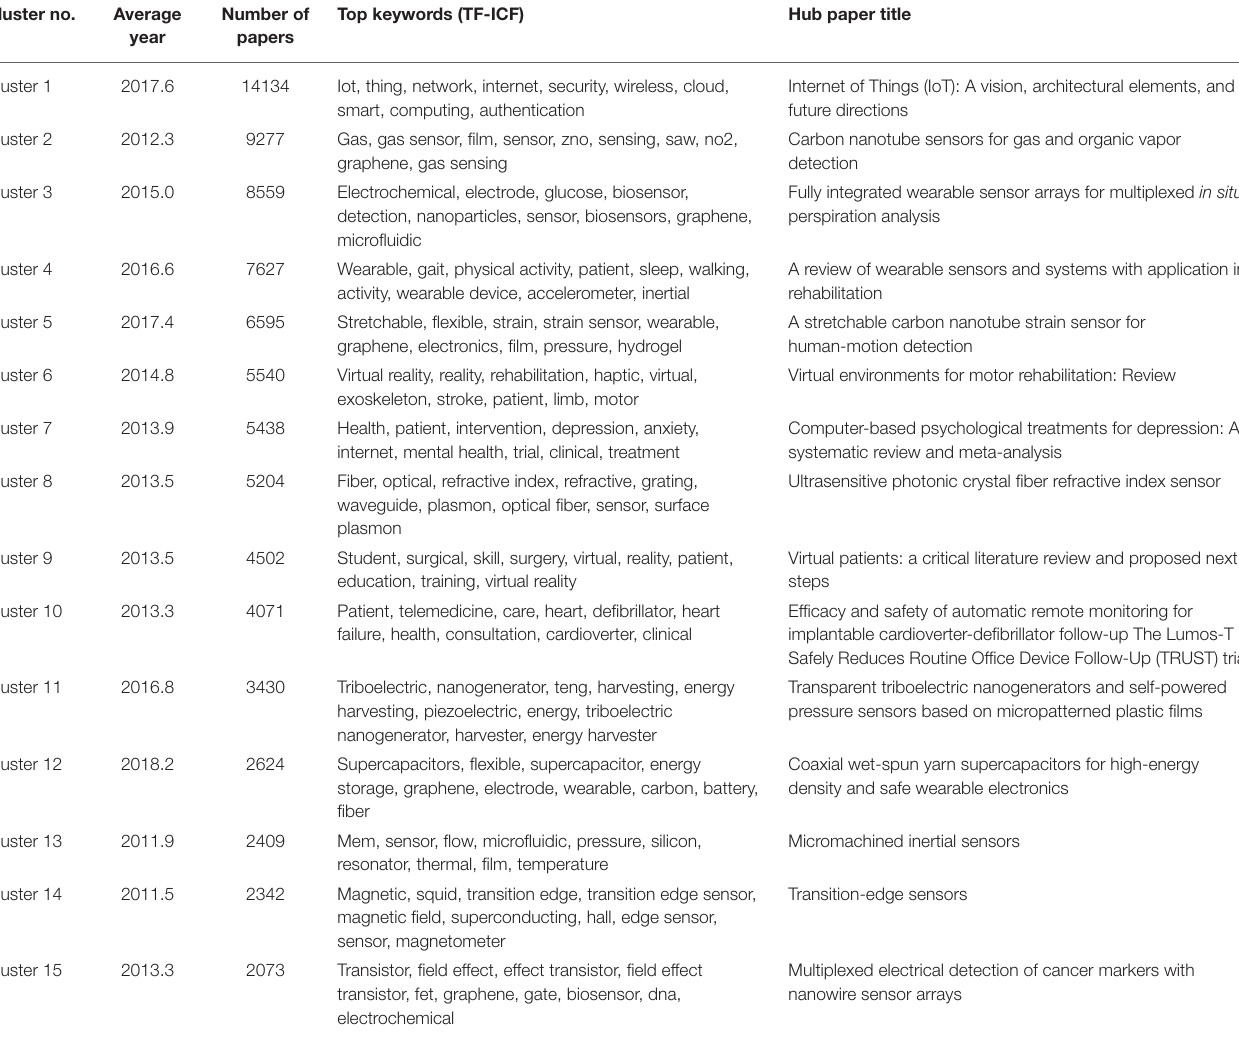
TABLE 1 | Information of top 15 clusters for IoM/IoHT. Cluster